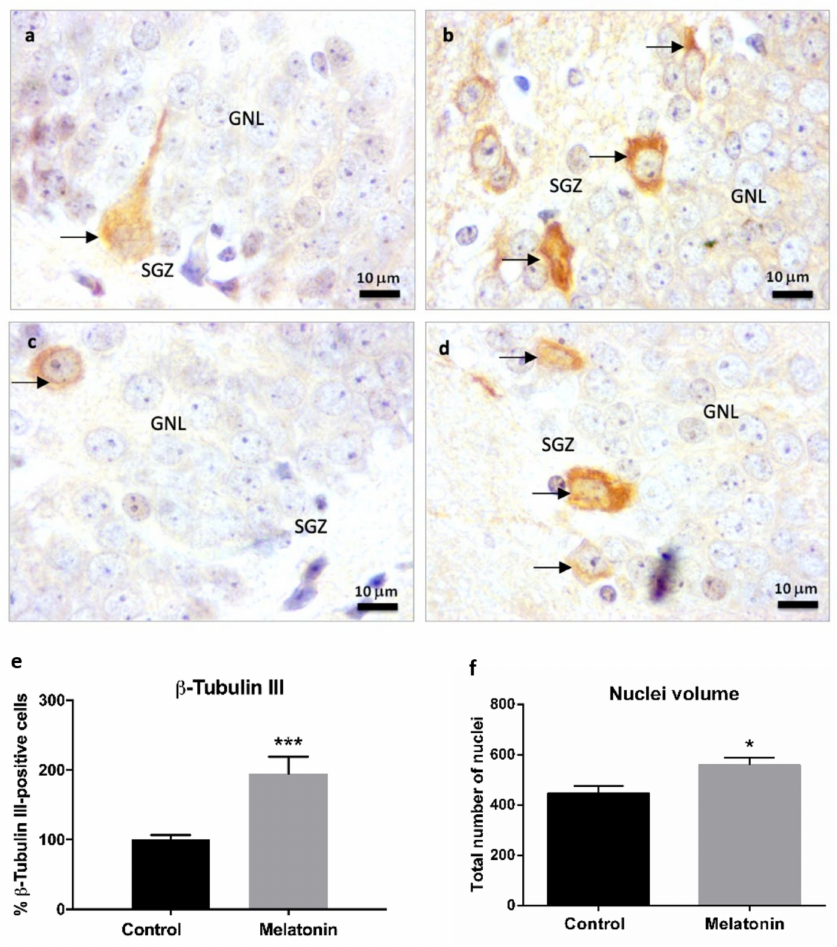
Figure 6. β -Tubulin III immunostaining in the granule neurons layer of the hippocampus of SAMP8 control mice ( a , c ) and SAMP8 mice treated with melatonin ( b , d ) at 1000 × magnifications. The arrows note possible newly created post-mitotic neurons. GNL, the granule neurons layer; SGZ, the subgranular zone. ( e ) Bar chart shows quantification of cells positive for β -Tubulin III in the GNL and SGZ of the hippocampus (in percentages with respect to the control). ( f ) Bar chart shows quantification of the total number of nuclei (nuclei volume) in the GNL and SGZ of the hippocampus. Data are always expressed as means ± SEM. * p < 0.05; *** p < 0.001 versus control. Statistical analysis was always performed in 10 images obtained from each SAMP8 control mice ( n = 4) and SAMP8 mice treated with melatonin ( n =